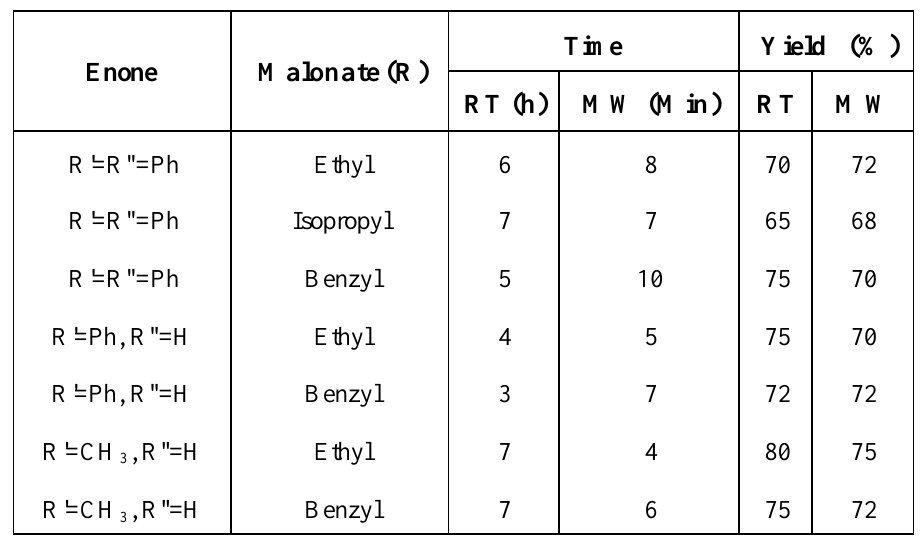
Table 2 , Michael additions of acyclic a , b -unsaturated enone with dialkyl malonates under microwave